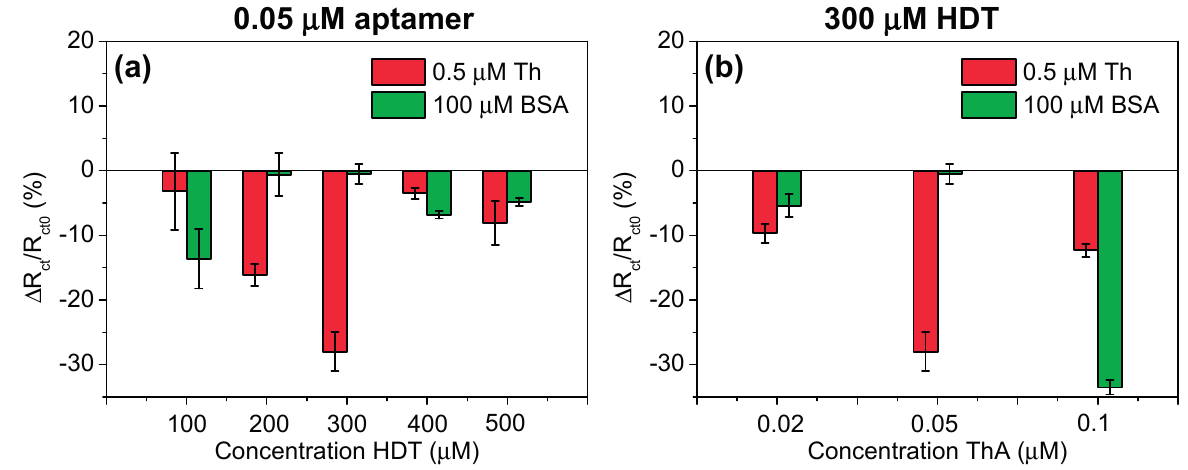
Figure 3. Charge transfer resistance ( R ct ) values variation obtained for incubation of thrombin aptamer (ThA) sensors with 0.5 µM of thrombin (Th, red bars) and 100 µM of bovine serum albumin (BSA, green bars). Figures represent the results obtained for different ratios of aptamer/hexanedithiol (HDT), for ( a ) 0.05 µM ThA and ( b ) 300 µM HDT. To improve anti-fouling properties on the polished gold surface, similar optimisations were also performed. Different concentrations of HDT in the range 200–400 µM were used but without any improvement of non-specific